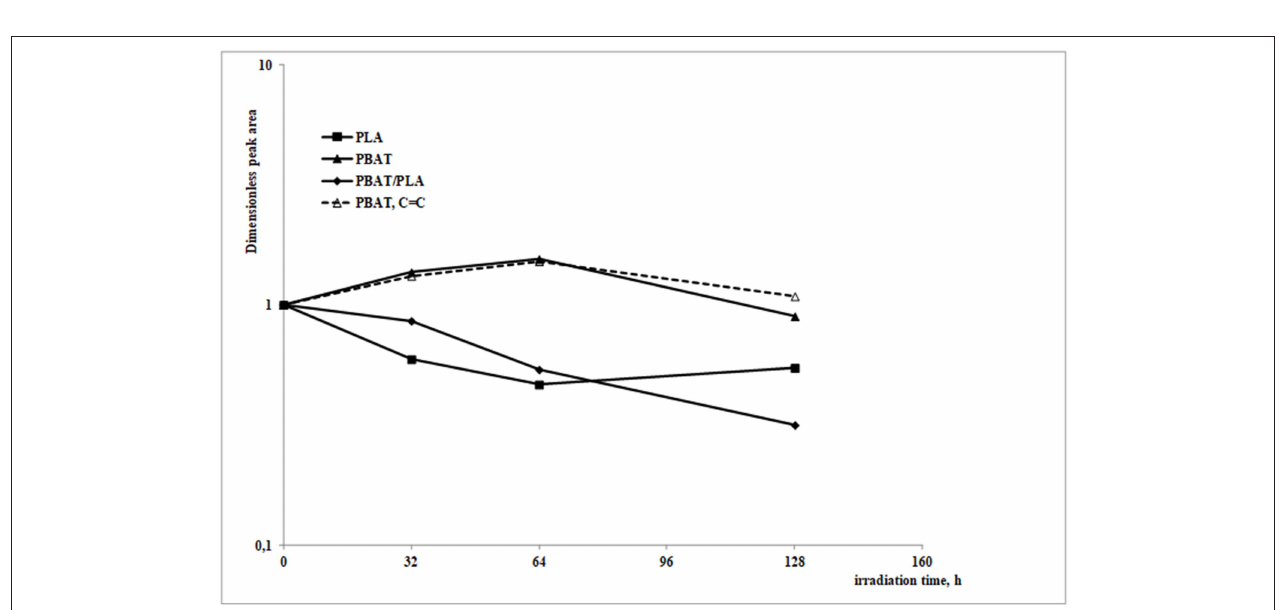
FIGURE 5 | Dimensionless peak area of the three investigated systems in the 1,860–1,600 cm − 1 region (continuous lines) and peak area of PBAT in the 900–1,100 cm − 1 region (dotted line), as a function of the irradiation time.